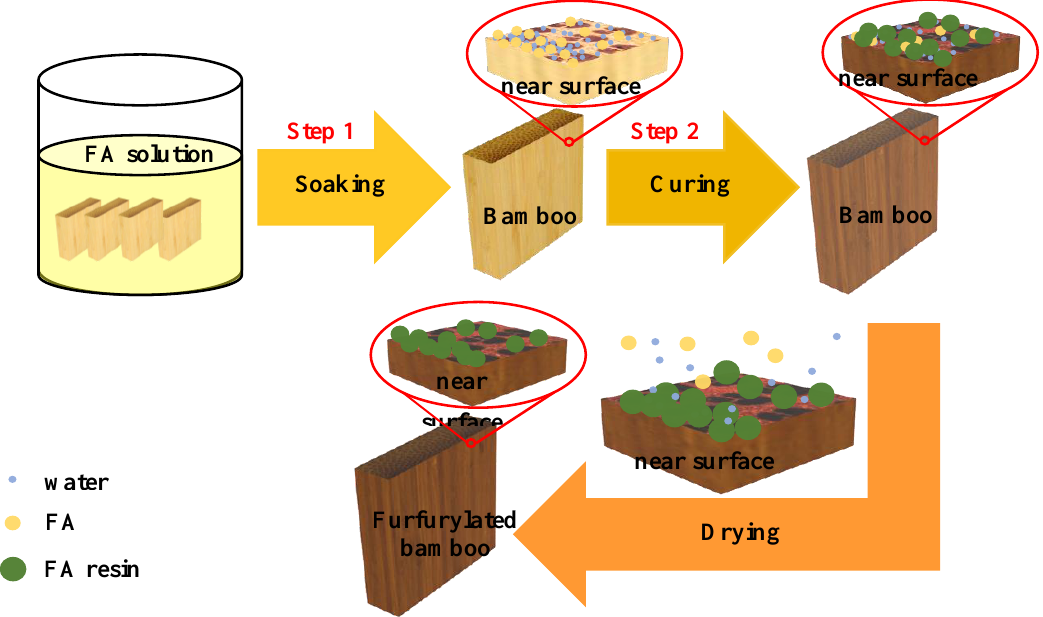
Figure 1. Schematic of wood modification via a simple soaking impregnation with FA: Step1, bamboo samples were soaked in the furfuryl alcohol (FA) solutions for 36 h under room temperature; Step 2, the soaked samples were wrapped in aluminum foils and then cured at 105 °C temperature for 5 h, during this process, FA polymerized into resin while a part of the FA remained unreacted and stored in bamboo; after further drying, the FA resin was further cured and the unreacted FA escaped